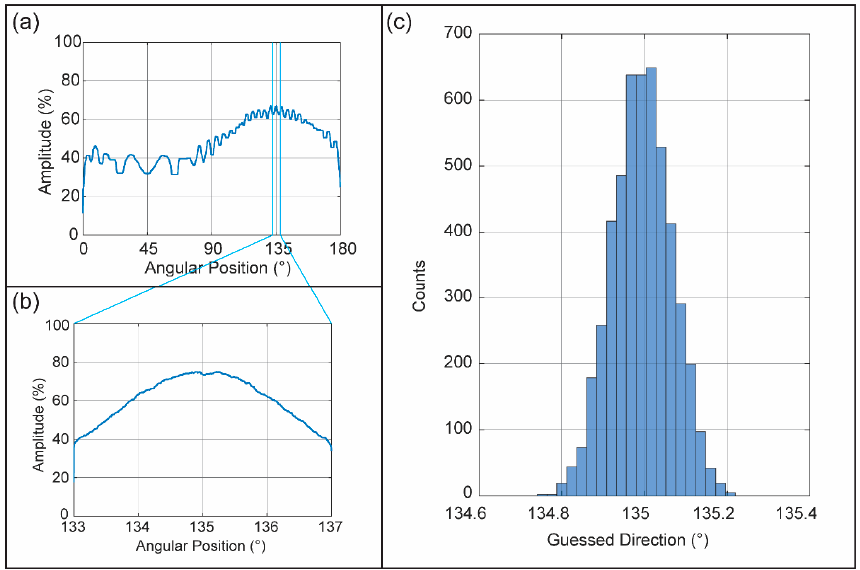
Figure 5. ( a ) Sensor signal response for one-half rotation when the transmitter was located at 135° with respect to the coordinate system with signal-to-noise ratio (SNR) = 2; ( b ) Signal response for the 4° high resolution scan area when the transmitter was at 135° with respect to the coordinate system with SNR = 2; ( c ) Histogram of the results of the direction-finding program used on the high-resolution scan area in ( b ). Over 5000 iterations, the program found the direction of the transmitter to be 134.99° ± 0.07° compared to a ground-truth value of 135°.